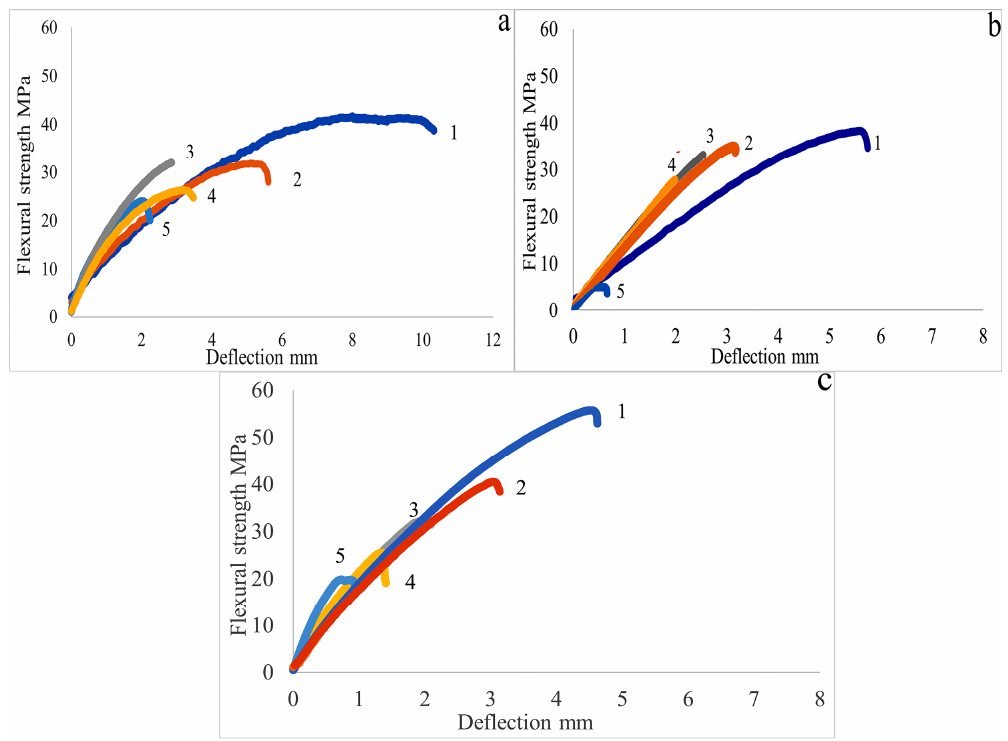
Figure 4. Flexural test curves of PSU based composites filled with 30 (1), 40 (2), 50 (3), 60 (4) and 70 (5) wt.% of NG ( a ), AG ( b ) and EG ( c ).